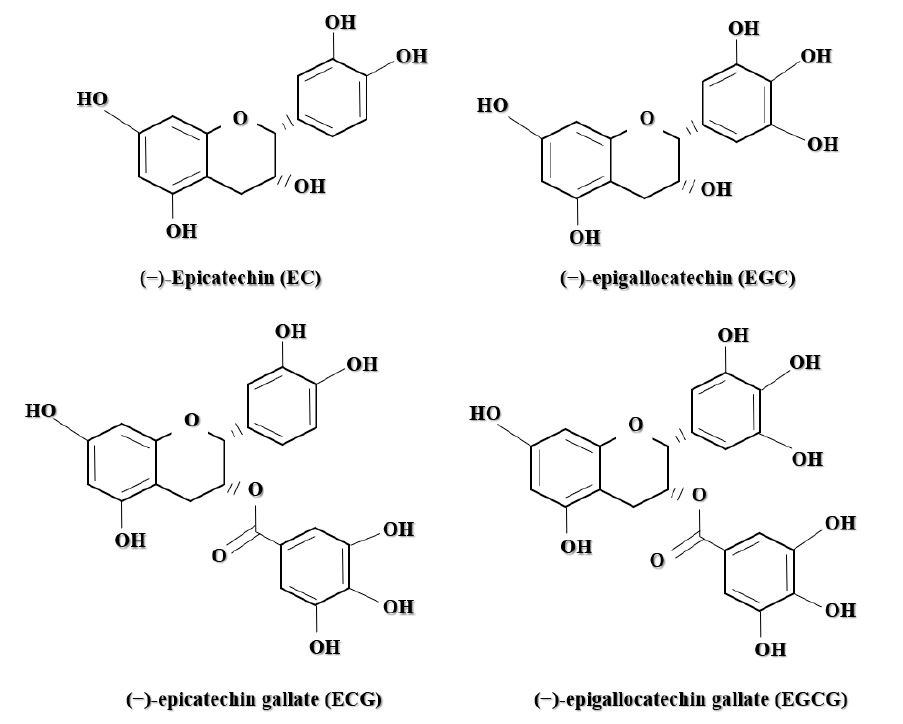
Figure 4. The chemical structure of four (4) primary polyphenols in Camelia sinensis : epicatechin (EC), epigallocatechin (EGC), epicatechin gallate (ECG), and epigallocatechin gallate (EGCG) .